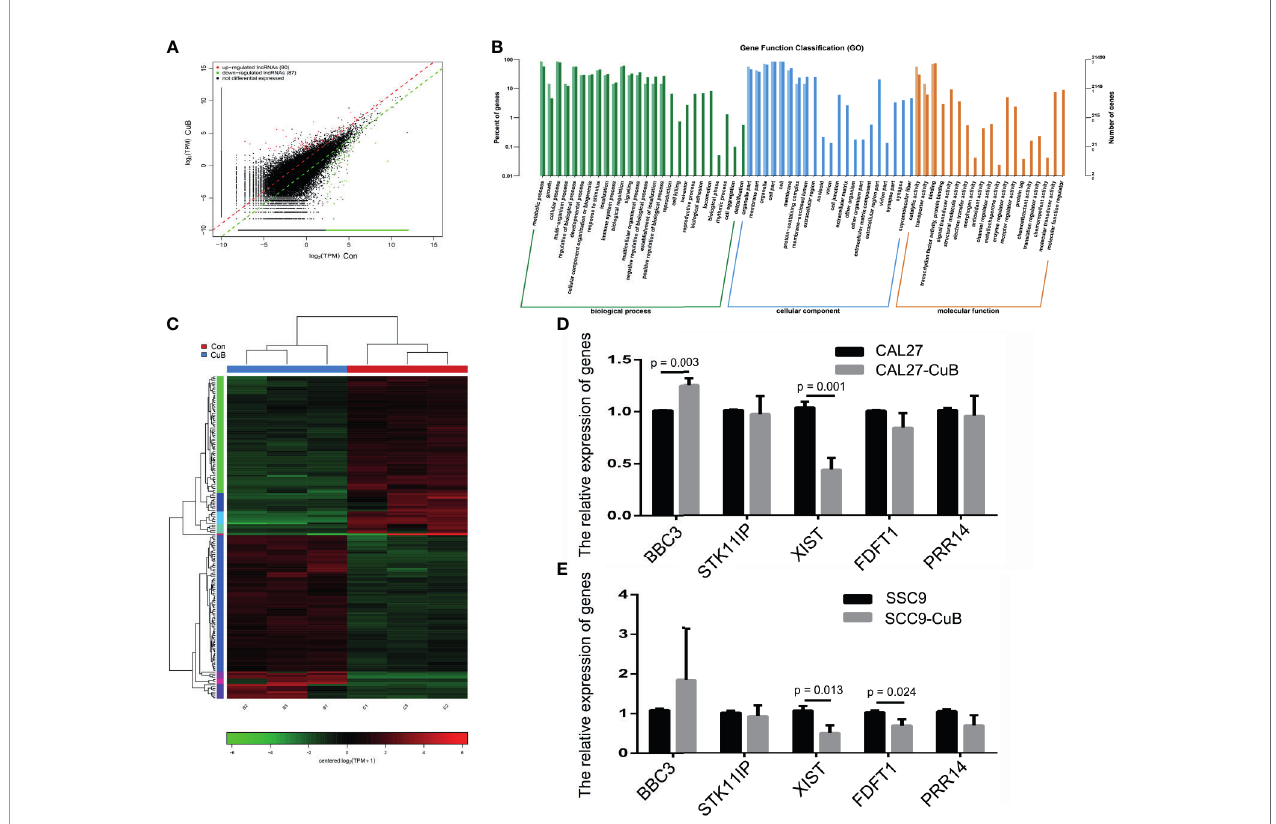
FIGURE 2 | LncRNA expression pro fi le by RNA-seq. (A) Identi fi cation of differentially expressed lncRNAs in SCC9 cells. (B) KEGG pathways associated with the differentially expressed lncRNAs. (C) Heatmap depicts the differentially expressed lncRNAs. (D) Relative expression of BBC3, STK11IP, XIST, FDFT1 and PRR14 were analyzed via qPCR post-CuB treatment of CAL27 cells. (E) Relative expression of BBC3, STK11IP, XIST, FDFT1 and PRR14 were analyzed in SCC9 cells. Data are expressed as mean ± SD (n = 3). Statistical signi fi cances between groups were evaluated using t-test for independent